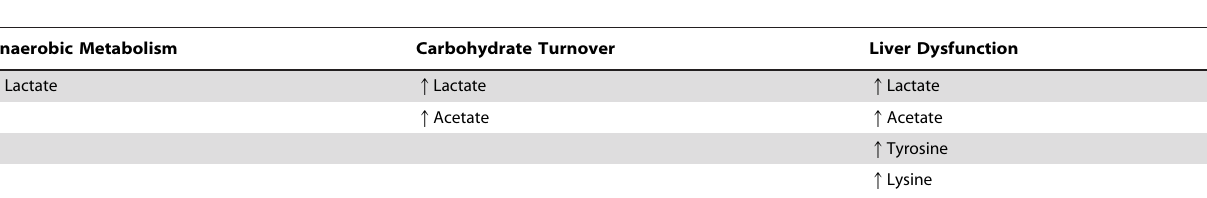
Table 3. 1 H–NMR plasma biomarkers predictive of poor prognosis after hemorrhagic shock-induced global ischemia/reperfusion